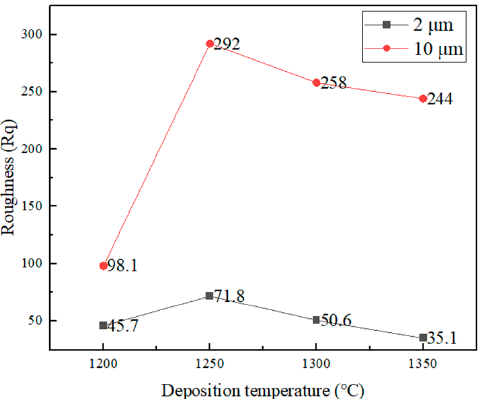
Figure 7. Surface roughness (Rq)/nm of HfO 2 coatings prepared at different deposition temperatures.